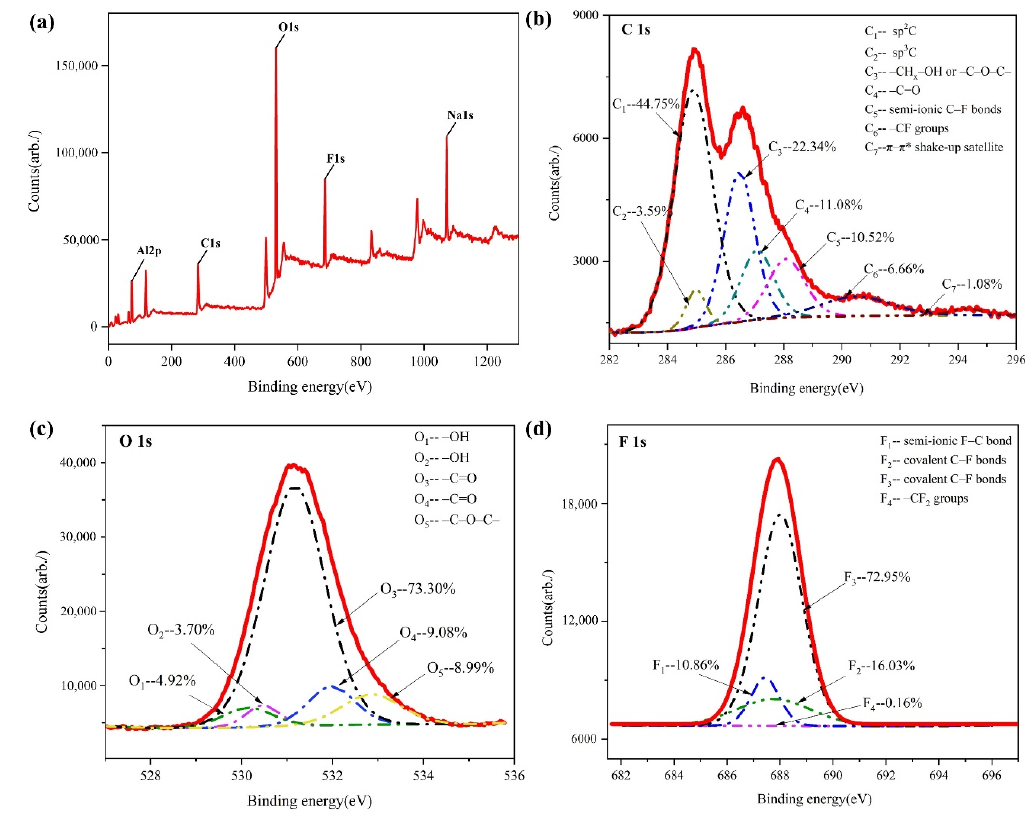
Figure 12. XPS spectra of graphite anode after electrolysis: ( a ) total spectra; ( b ) high-resolution C1s peak and its fitting results; ( c ) high-resolution O1s peak and its fitting results; ( d ) high-resolution F1s peak and its fitting results.